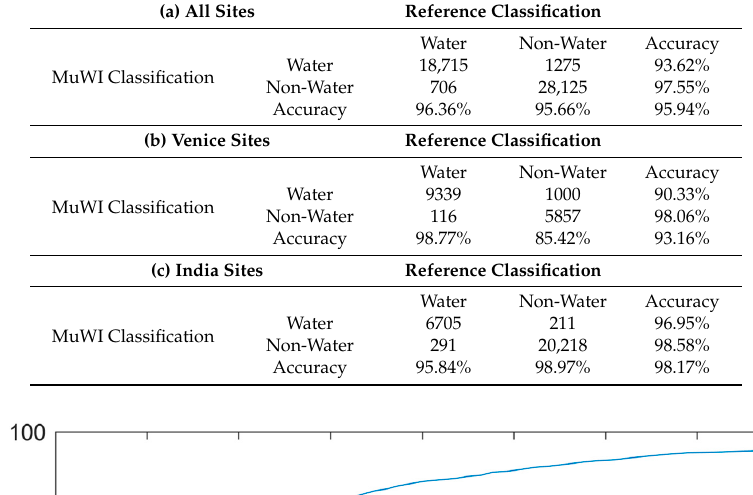
Table 3. Confusion matrixes of MuWI mapping results on ( a ) entire testing sites, ( b ) Venice testing sites, and ( c ) India testing sites.